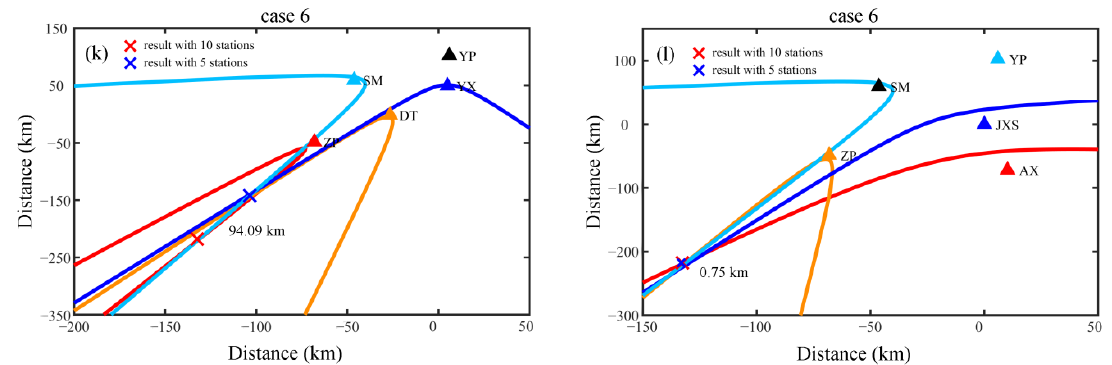
Figure 8. The configuration of five stations under the maximum and minimum deviation distance for six cases. The left-side subplots describe the worst configurations while the right-side are the best configurations. ( a , b ) correspond to the results of case 1. ( c , d ) correspond to the results of case 2. ( e , f ) correspond to the results of case 3. ( g , h ) correspond to the results of case 4. ( i , j ) correspond to the results of case 5. ( k , l ) correspond to the results of case 6. The hyperbolas of different colors correspond to the arrival time differences between the center station (black triangle) and the station of same color as the hyperbola. The red crosses mark the reference location. The blue cross represents the location under the configuration of five stations.